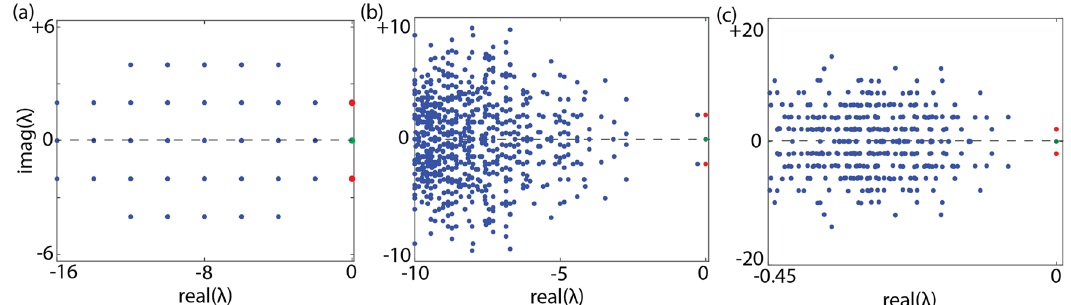
Fig. 1 Liouvillian gap closure and the signature of the non-stationary phase. Liouvillian spectrum of noninteracting Kitaev chain for different chain length a N = 4, b N = 12, and c N = 100 subject to periodic boundary conditions. In all cases the chemical potential, hopping amplitude, and pairing potential are μ = 0, w = 1, Δ = i , respectively. The red and green dots show the pure imaginary and zero eigenvalues,